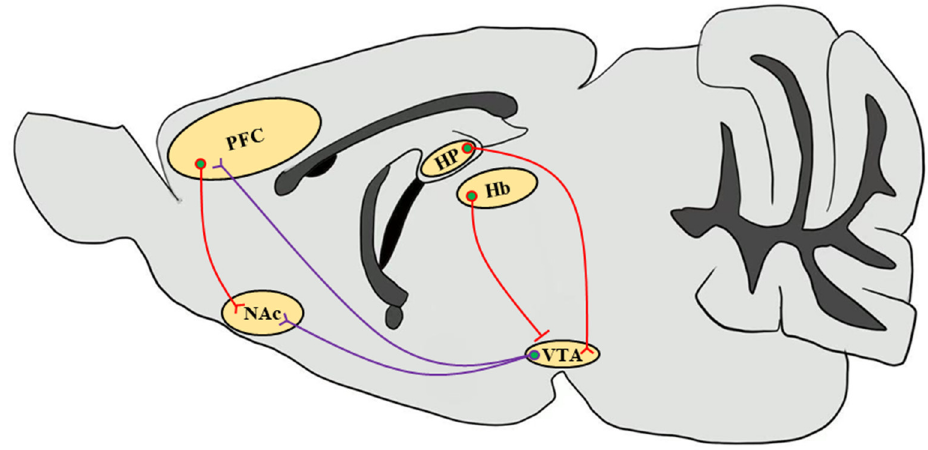
Figure 1. Simplified schematic representation of the mouse brain reward circuitry. The scheme of the mesolimbic DAergic projections (purple) of the mouse brain sagittal section emphasizes the predominant afferents that originate in the VTA and input into the NAc as well as the PFC, which are modulated by stimulant drug exposure through CaMKII functions. Glutamatergic inputs (red) that regulate neuronal circuits in response to drug abuse from the PFC to the NAc and from the HP to the VTA through the subiculum are highlighted [81]. Since CaMKII β regulates synaptic activity in the Hb in the context of depressive behaviors, it increases glutamatergic inputs onto VTA GABAergic interneurons to inhibit VTA DAergic neurons, thereby decreasing the DA release in the NAc [82,83]. VTA, ventral tegmental area; NAc, nucleus accumbens; PFC, prefrontal cortex; HP, hippocampus; Hb, habenula.